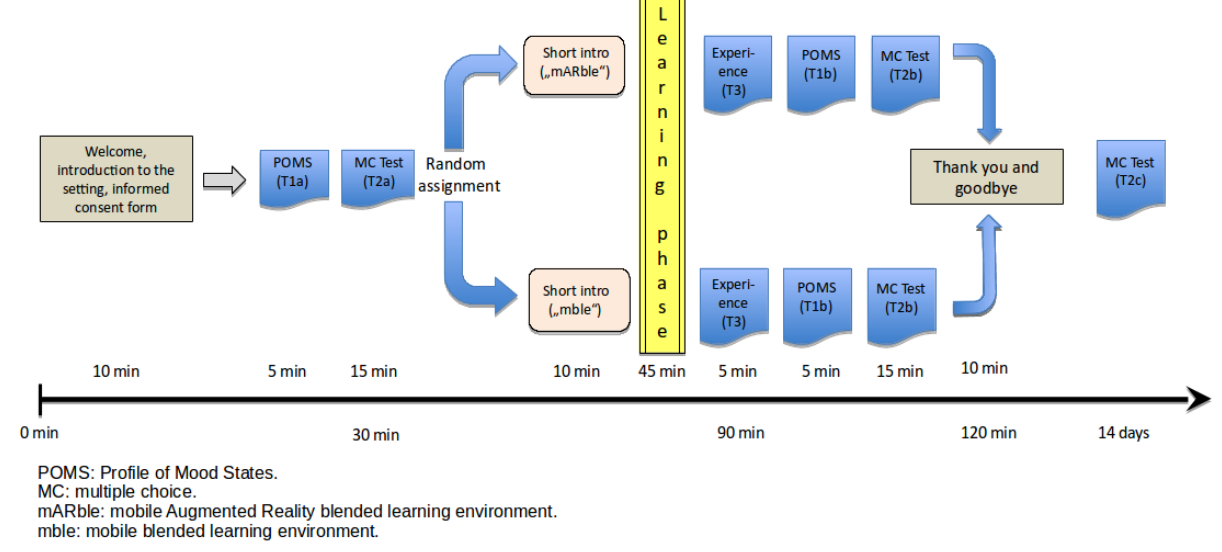
Correct answers,